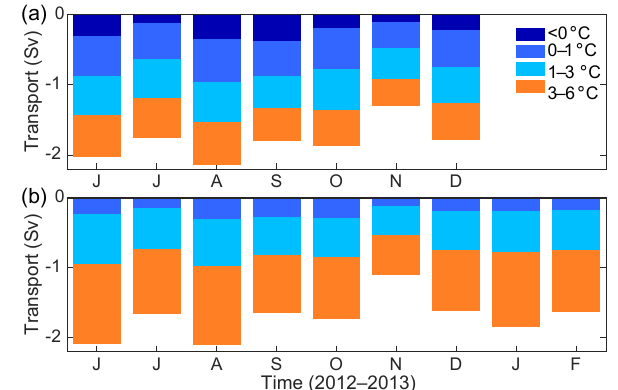
Figure 8. Time series of monthly mean temperature anomalies ( ◦ C) at 25mab from three moorings along the plume path (C2, M1, and S2; see labels on the left). Each series is shown as a fluctuation about the whole deployment mean, indicated by numbers below each axis (on the left). Scale bar is given in the top right corner.